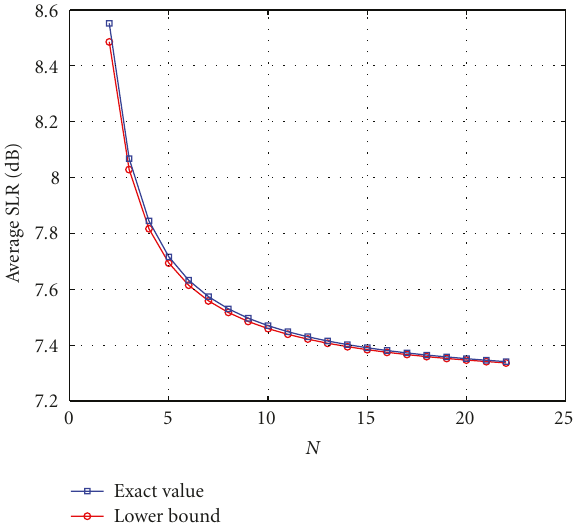
Figure 5: Exact average SLR and its lower bound in (31) as a function of N for the user i = 1 ( w i is obtained from (32), and Gaussian AoA model is used).